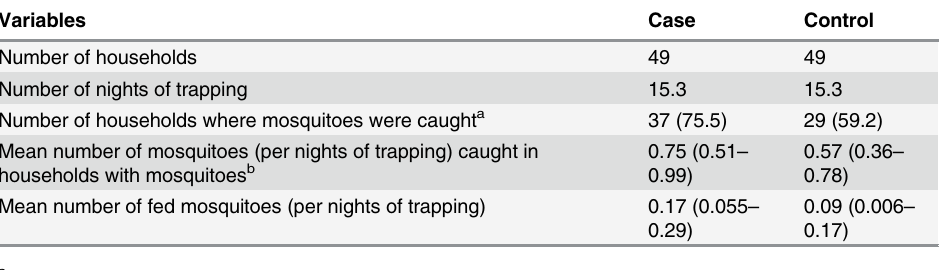
Table 4. Entomological